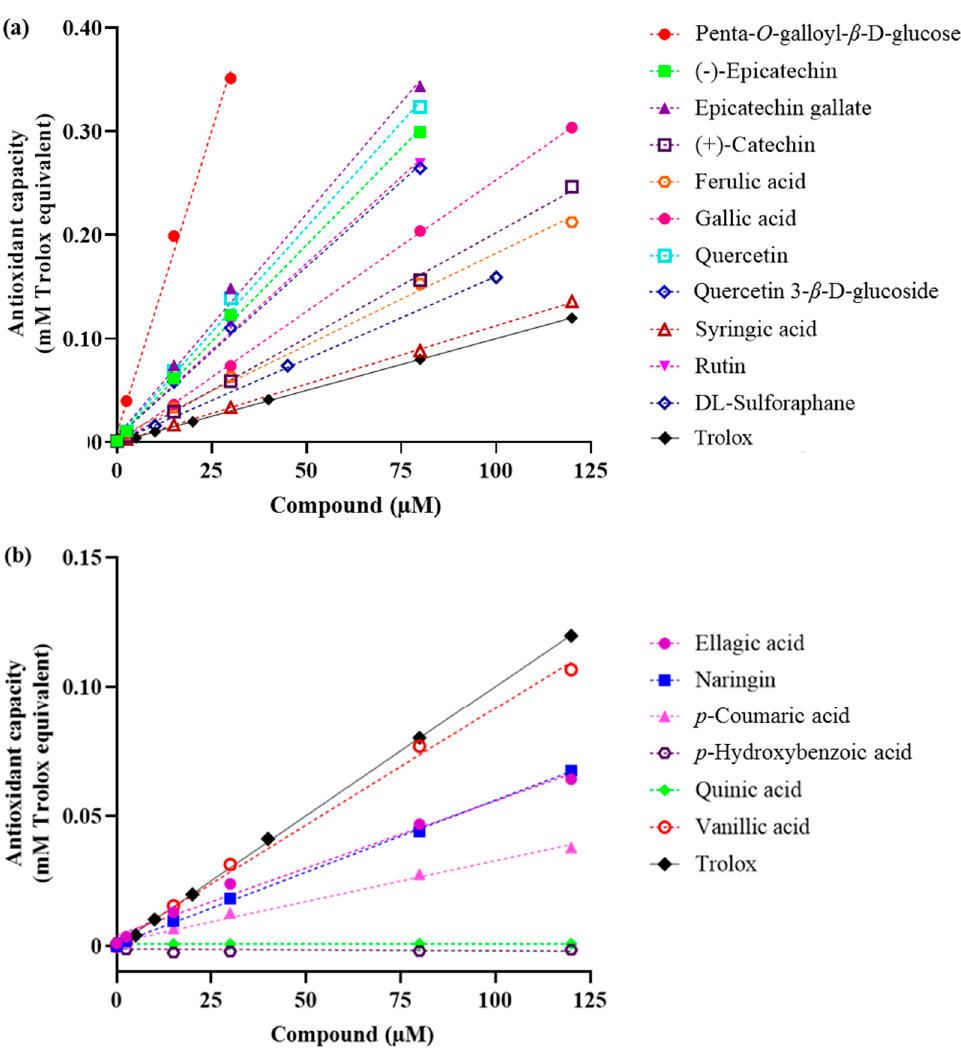
Figure 1. Total antioxidant activity of phenolic compounds in black walnut. ( a ) Compounds with higher antioxidant capacity than Trolox, ( b ) compounds with lower antioxidant capacity than Trolox. Linear regression models of the majority of tested compounds had high R 2 values ( > 0.98), indicating that these models were reliable (Table 1). Models of two compounds ( p -hydroxybenzoic acid and quinic acid) had low values of R 2 since these compounds had minor or no antioxidant capacity under the experimental conditions. Violin plots representing the data distribution of controls (Trolox and tert-butylhydroquinone) showed a relatively small variation of data, indicating that the HTS assay system was reliable (Supplementary Figures S1 and